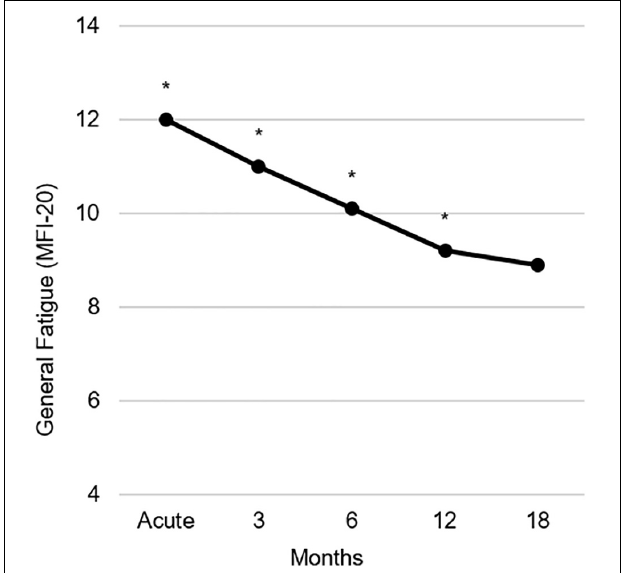
FIGURE 1 | Observed course of the mean General Fatigue measured with the multidimensional fatigue inventory (MFI-20) during 18 months postburn. Asterisks indicate significant differences from population norms (Schwarz et al., 2003), with p s ≤